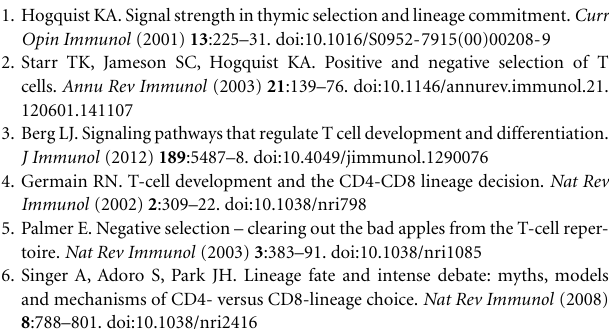
Figure S1 | General gating strategy for the identification of innate (B6)T cells, and SLAMF receptor expression by FACS . (A) Genomic organization of the nine SLAMF genes, and the two adaptors Sh2d1b1 and Sh2d1b2 (encoding EAT-2A and ERT, respectively) on the murine chromosome 1H3. Blue filled boxes with a red frame represent SLAMF receptors containing one or more ITSM. Black empty boxes represent SLAMF receptors that lack ITSM. Red and orange boxes represent the Sh2d1b1 and Sh2d1b2 genes, respectively.This diagram also illustrates the Slamf[1 + 6] − / − and Slamf[1 + 5 + 6] − / − deletions used in this manuscript. (B) FACS plots showing the main gating strategy used on the analysis of NKT and innate CD8 + T cells in B6 mice. Upper row from left to right: live cells (DAPI negative), singlets, lymphocytes, and total thymocytes depicting the NKT (CD1d-Tet + TCR β inter ), theTCR β hi mature, andTCR β low immature thymocytes gates. Middle row from left to right: CD4 + CD8 + DP TCR β low immature thymocytes, mature (CD44 + NK1.1 + ) NKT cells,TCR β hi mature T cells [depicting CD8 and CD4 single positive (SP) mature thymocytes], and CD8SPT cells depicting the innate CD8 + T cell population in the thymus. Bottom row from left to right, mature (CD44 + NK1.1 + ) NKT cells,TCR β + T cells [depicting CD8 and CD4 single positive (SP) splenocytes], and CD8SPT cells depicting the innate CD8 + T cell population in the spleen. (C) Representative FACS staining of innate CD8 + T cells (CD44 hi CD122 + TCR β + ) showing the corresponding fluorescence minus one (FMO) negative control for the CD122 gate in thymus and spleen fromWT cells. (D) Representative FACS histograms showing the expression of Slamf1, Slamf2, Slamf3, Slamf4, Slamf5, and Slamf6 on the surface of CD4 + CD8 + DPTCR β low thymocytes (upper row, green ), CD1d-tetramer (CD1d-Tet) reactive CD44 hi NKT cells ( red , NKT), or on CD44 hi CD122 + TCR β hi (thymus, middle row ), orTCR β + (spleen, bottom row ) CD8SPT cells ( purple , innate-like CD8) of 10-week-old B6 mice. Gray histograms represent the FMO negative control for the Slamf staining. Figure S2 | General gating strategy for the identification of innate (BALB/c) T cells by FACS . (A) FACS plots showing the main gating strategy used on the analysis of NKT and innate CD8 + T cells in BALB/c mice. Upper row from left to right: live cells (DAPI negative), singlets, lymphocytes, and total thymocytes depicting the NKT (CD1d-Tet + TCR β inter ), and theTCR β hi mature lymphocyte gates. Bottom row from left to right: total live thymocytes depicting the CD8 single positive (SP), the CD4SP, and the CD4 + CD8 + DPTCR β low immature thymocytes. (B) Representative FACS staining of innate CD8 + T cells (CD44 hi CD122 + TCR β + ) showing the corresponding FMO (fluorescence minus one) negative control for the CD122 gate ( left ), or Eomesodermin (Eomes, right ) in thymus and spleen fromWT